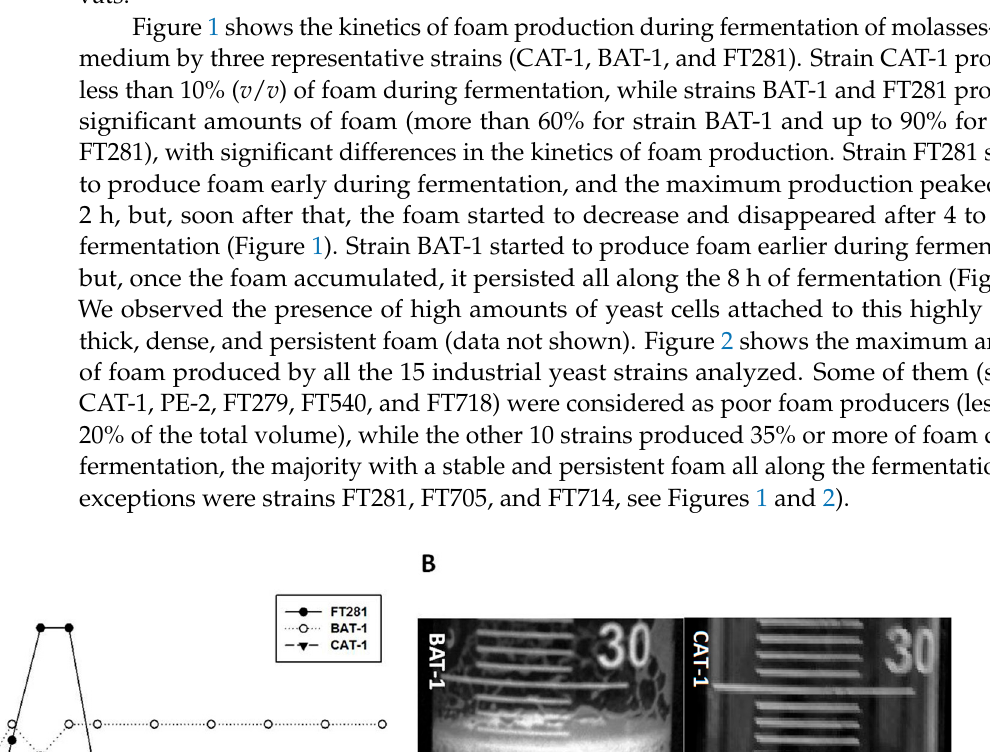
Figure 2. Foam produced during fermentation (volume of foam as a percentage of the media vol- ume) by the analyzed industrial fuel-ethanol yeast strains. White columns are strains that produce small amounts of foam, gray columns are strains that produce a non-persistent foam, and persis- tent foaming strains are in black columns. 3.2. Flocculation and Cellular Hydrophobicity of Industrial Yeast Strains Yeast strains were grown in molasses-based medium and flocculation assays were performed in the presence or absence of 20 mM Ca 2+ , and at least three different patterns of yeast flocculation were observed (Figure 3). Six industrial strains showed a high cel- lular sedimentation (>60% of flocculation), which was mostly calcium independent and only one of them (strain FT718) was not a strong foam producer (see Figure 2). A second group included four industrial yeast strains that presented calcium-dependent floccula- tion, as the sedimentation rate in absence of calcium was lower than 30%, but increasing